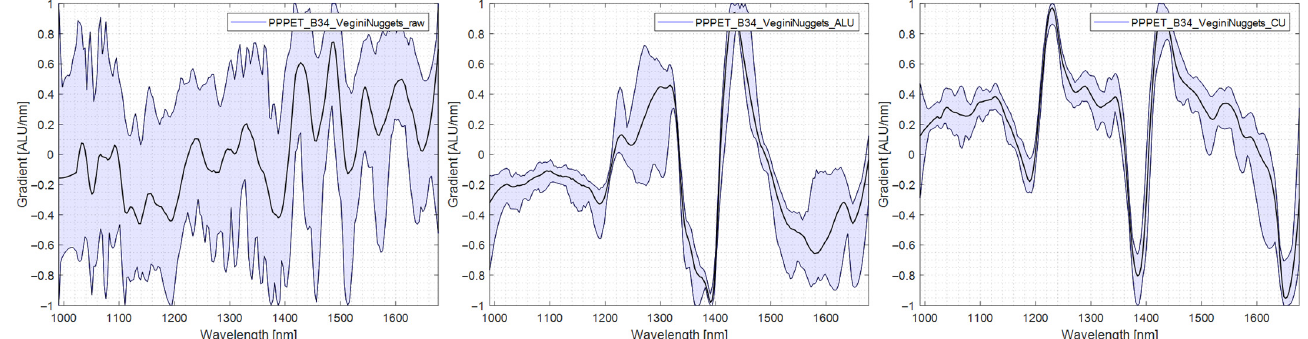
Figure 17. Comparison PP/PET spectra, left: no reflector, middle: aluminium reflector, right: copper reflector.